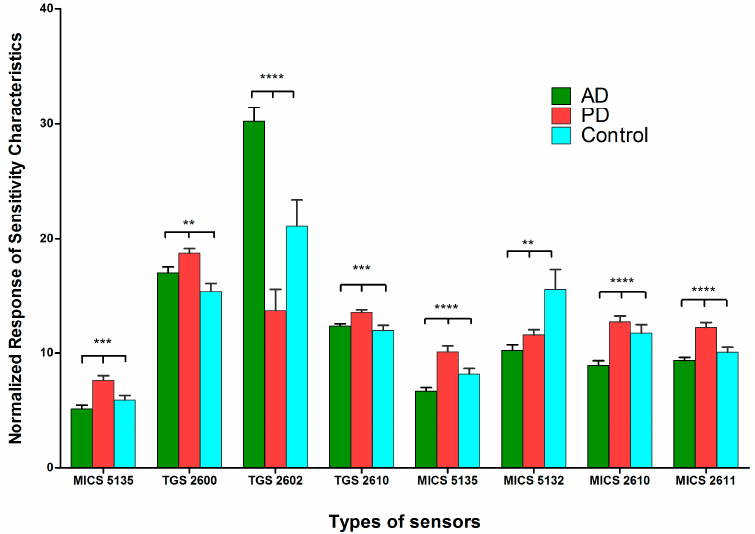
Figure 2. Normalized responses of the sensitivity characteristics for different types of gas sensors (System A). Response sensitivity of exhaled breath samples from the patients with Alzheimer’s disease (AD), Parkinson’s disease (PD), and from healthy individuals as a control group to gas sensors. The data are represented as mean ± standard deviation. The p -value was calculated using one-way analysis of variance (ANOVA). Differences were considered significant when the calculated ** p ≤ 0.01, *** p ≤ 0.001, and **** p ≤ 0.0001.